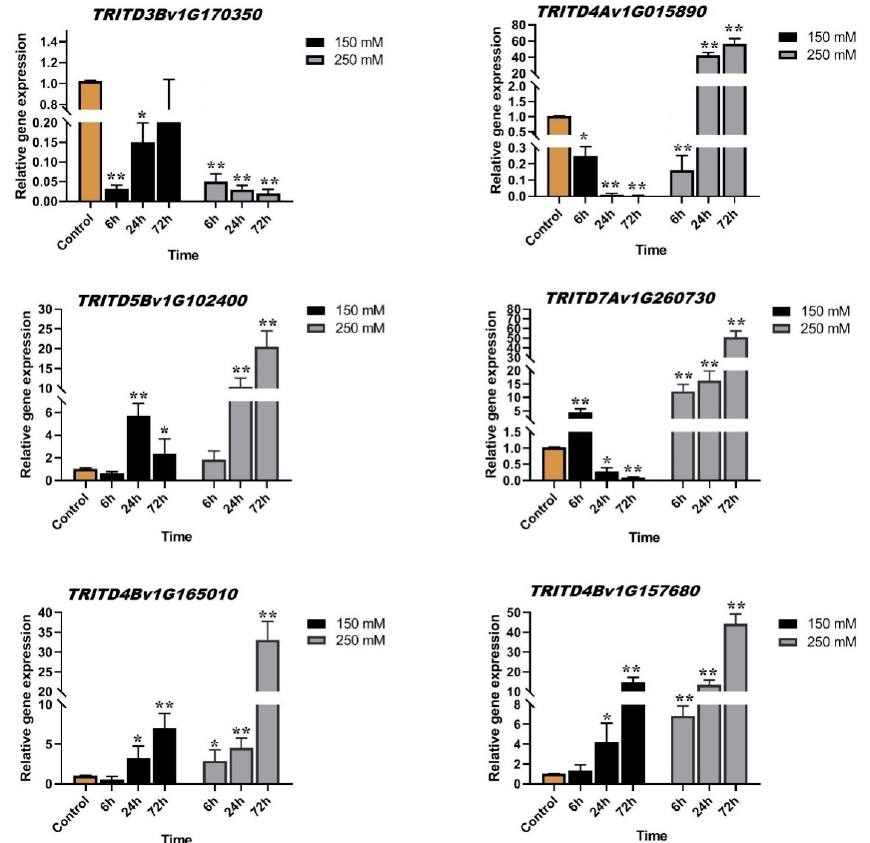
Figure 6. Expression levels of candidate TdSULTR genes in durum wheat in response to salinity, 150 and 250 mM of NaCl. * and ** indicate a significant difference between the experimental treatments and control treatment (according to Student’s t-test) at p < 0.05 and p < 0.01, respectively.